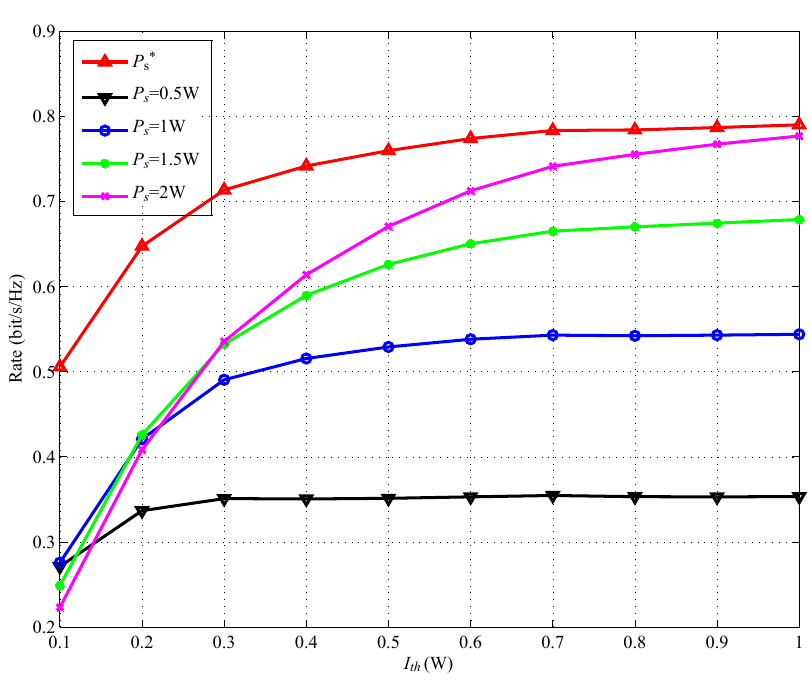
Figure 7. Achievable rate for various P s versus I th